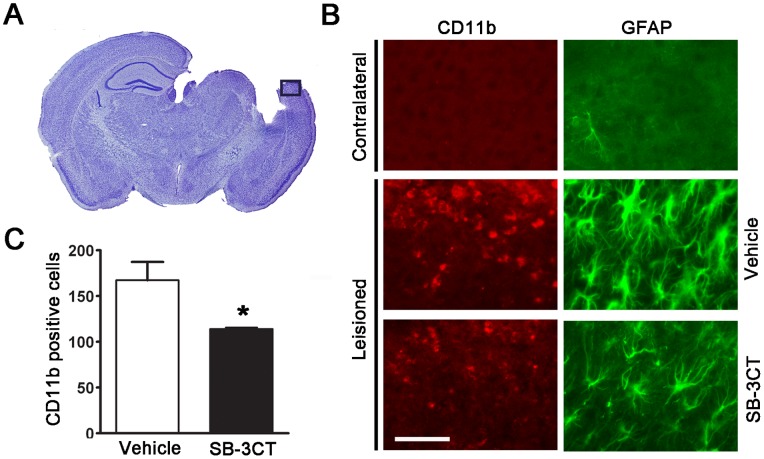
SB-3CT suppressed microglia activation and astrogliosis 7 days post-trauma.
A. A representative microphotograph showing the cortical area for glial cell activation analysis. B. photomicrographs of cortical region in coronal sections of mouse brain immunofluorescently stained with microglial marker CD11b and astrocytic marker GFAP showing increased astroglial activity 7 days post-trauma. SB-3CT treatment attenuated activation of microglia and astrocytes in the lesioned cortex. Scale bar = 50 µm. C. Numbers of the CD11b positive microglia were counted from a total of approximately 1600 cells in the area showed in A
. The number of CD11b positive microglia was significantly lower in the lesioned cortex of SB-3CT-treated mice compared to vehicle-treated animals; n = 3 for each group; *, p<0.05 by one-tailed, unpaired Student’s t-test. Data are expressed as mean ± SEM.